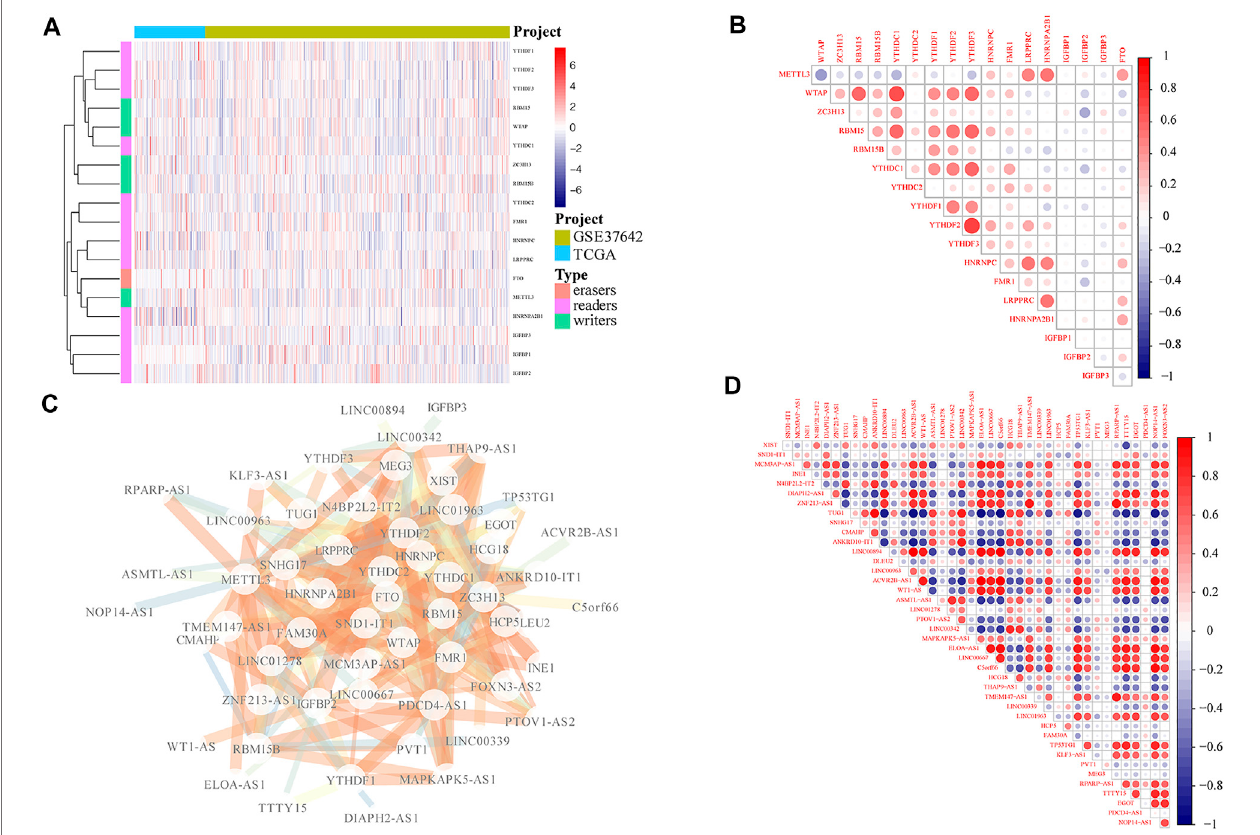
FIGURE1 | Screening ofm6A-related lncRNAs. (A) Expression ofm6A-related genesin AML patients from TCGA and GEO databases. (B) Heatmap showing the co-expression correlation of m6A-related gene in AML patients. (C) Based on correlation screening, 41 signi fi cant m6A-related lncRNAs were obtained. (D) Correlation analysis of the expression level of 41 signi fi cant m6A-related lncRNAs in AML patients in TCGA and GEO datasets, in which the color intensity was proportional to the degree of correlation; the deeper red color indicates more positive correlation, and the deeper blue color represents more negative